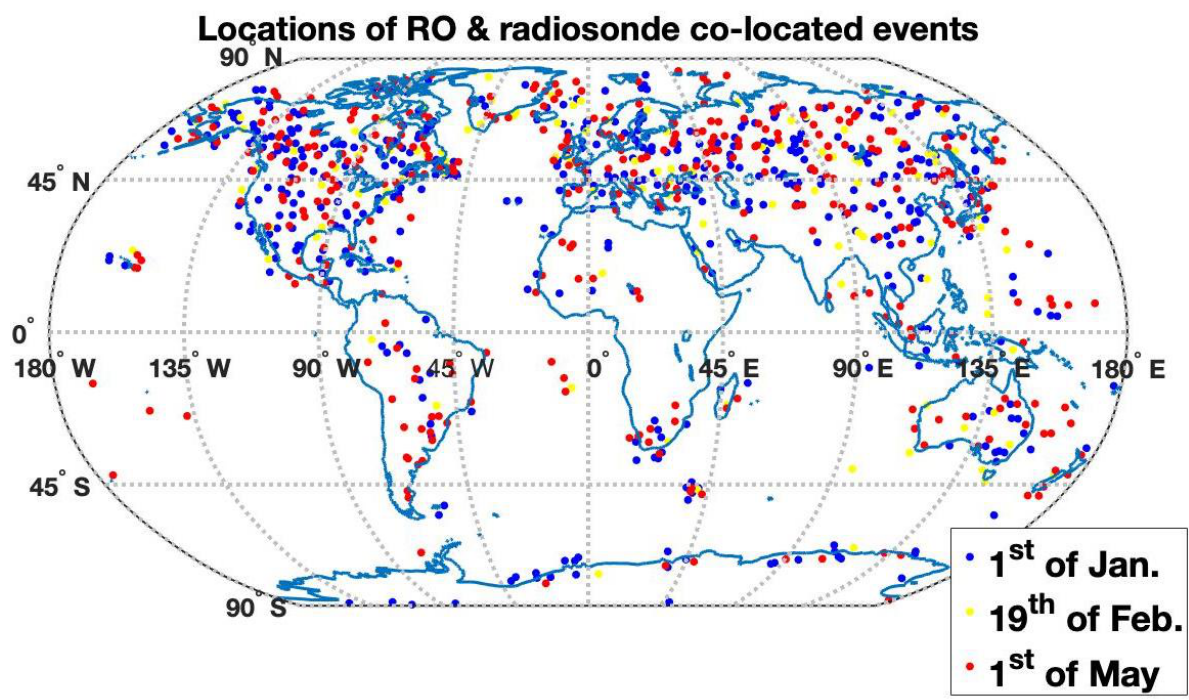
Figure 4. Event locations for the RO observations colocated with radiosonde excursions considered in this study, taking place on the 1st of January (422 events), the 19th of February (118 events) and the 1st of May (372 events). Table 1. Mean values of altitude, temperature, temperature − dry temperature and relative pressure − dry pressure differ- ences together with the number of samples corresponding to given values of mixing ratio. Uncertainties are also given in brackets.